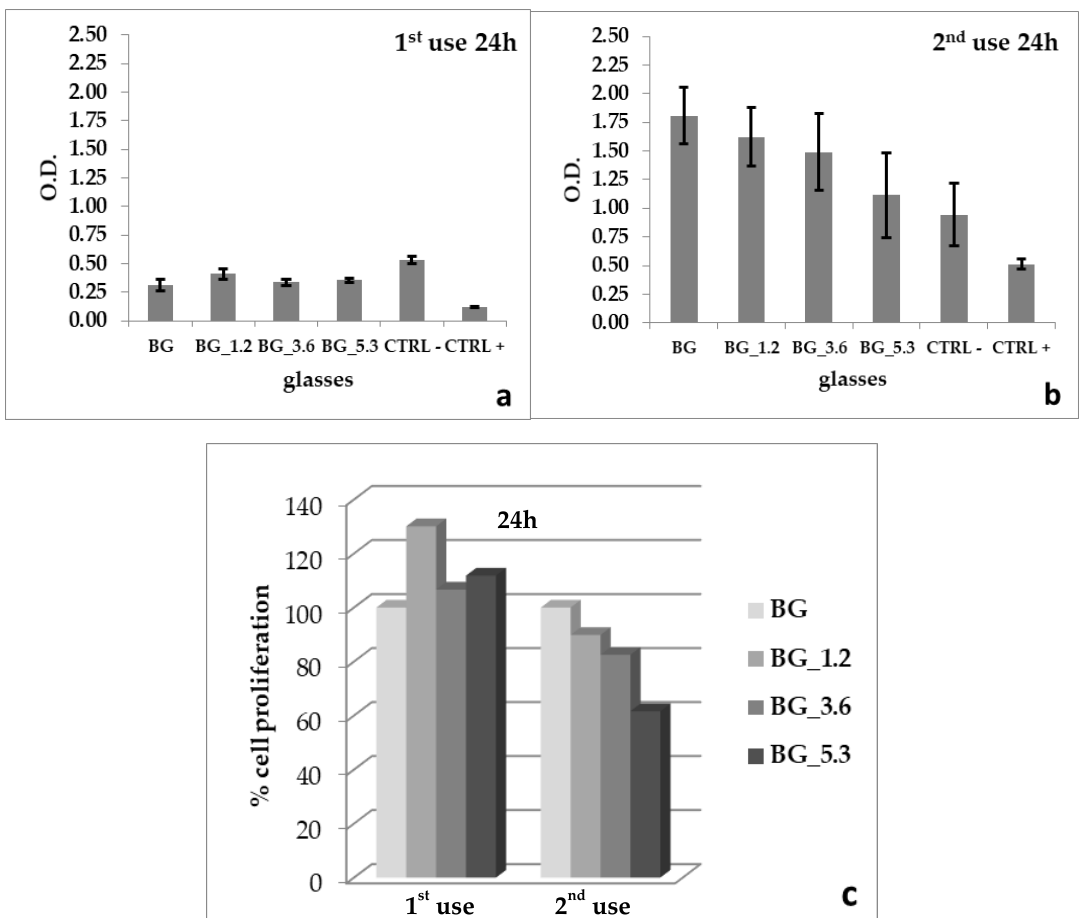
Figure 3. Bromo-2-deoxyUridine (BrDU) uptake with MLOY4 cell lines after ( a , b ) 24 h for BG, BG_1.2, BG_3.6 and BG_5.3, together with negative (CTRL − ) and positive (CTRL + ) controls; errors bars represent standard deviation. Comparison between doped glasses among the first and second use for 24 h ( c ).